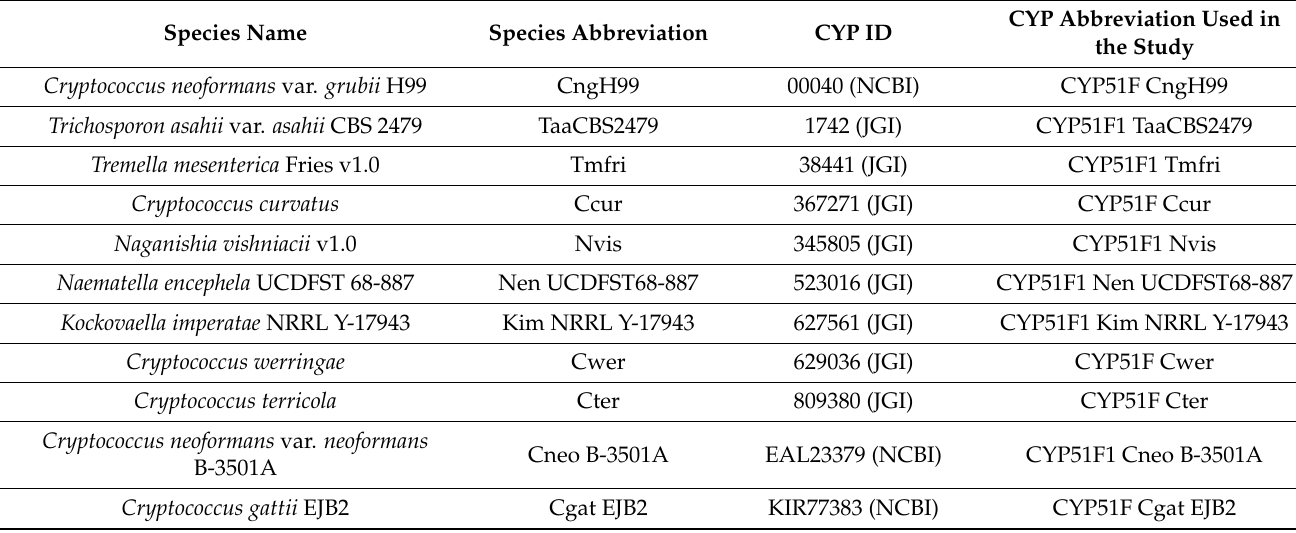
Table 3. Information on CYP51s from Tremellomycetes used for structural analysis in this study. Amino acid sequences of CYP51s have been retrieved from the published data [34] and used in the study. The databases used for collecting CYP51 sequences were presented in parenthesis under the P450 ID